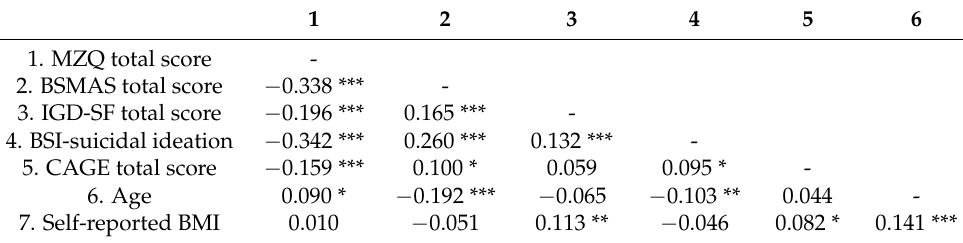
Table 2. Associations between variables in the sample (N =